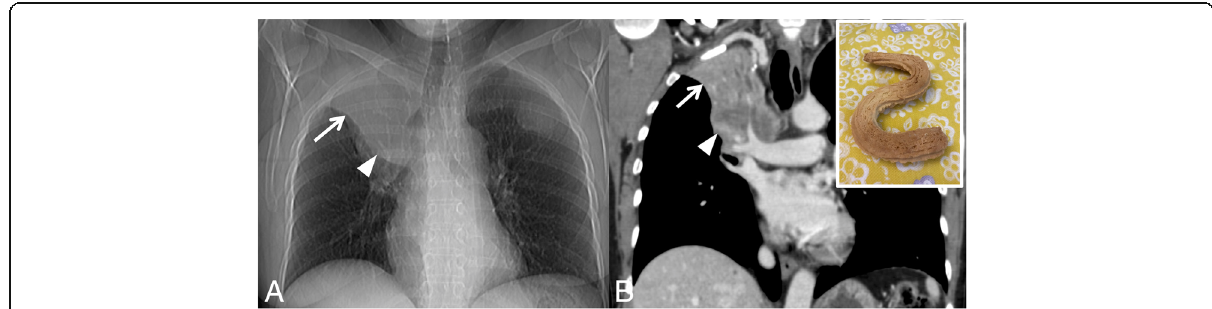
Fig. 17 Golden S sign. The Golden S-sign reproduced in a patient affected by right pulmonary carcinoma. An “ S ” profile is clearly shown in a : this appearance is created by the right upper lobe atelectasis (superior and lateral part of the S profile) and by pulmonary neoplasm at the right hilum (inferior and medial part of the S profile). The same appearance is well depicted in coronal MPR CT image ( b ), very similar to the “ S ” profile of the biscuit reproduced in the embedded figure